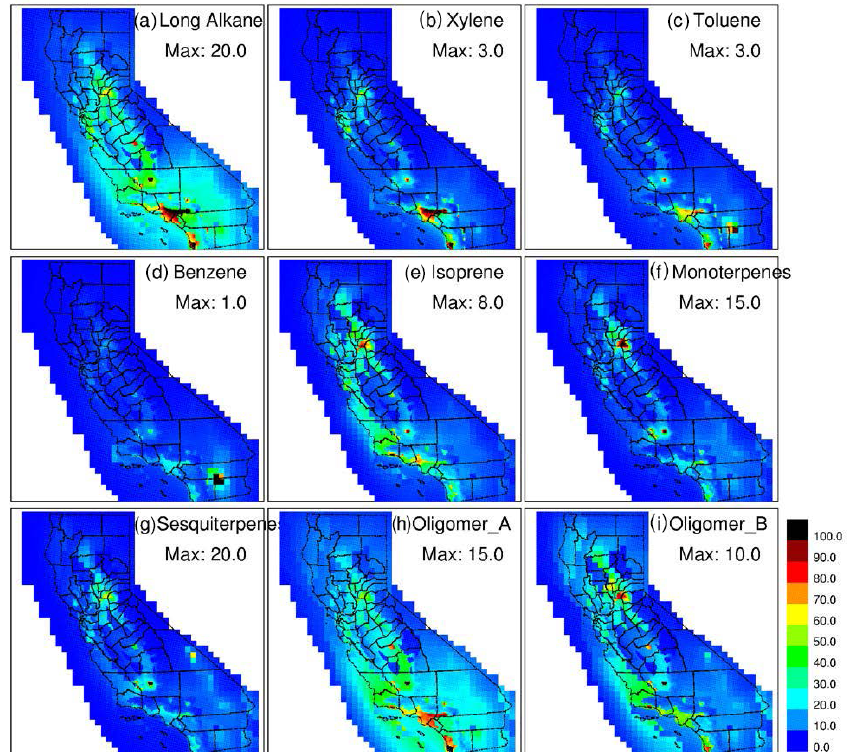
Figure 5. The 9-year average PM 0 . 1 SOA concentrations derived from (a) AALK, (b) AXYL, (c) ATOL, (d) ABNZ, (e) AISO, (f) ATRP, (g) ASQT, (h) AOLGA, and (i) AOLGB. Note that AXYL and ATOL are actually derived from lumped aromatics species ARO2 (groups of aromatics with kOH>2 × 10 4 ppm − 1 min − 1 , including xylenes and other di- and polyalkylbenzenes) and ARO1 (groups of aromatics with kOH< × 10 4 ppm − 1 min − 1 , including toluene and monoalkylbenzenes). The color scales (shown in the last panel in unit of %) indicate the ratios of the concentrations to the maximum 9-year average values, which are shown in the panels under species names with a unit of ngm − 3